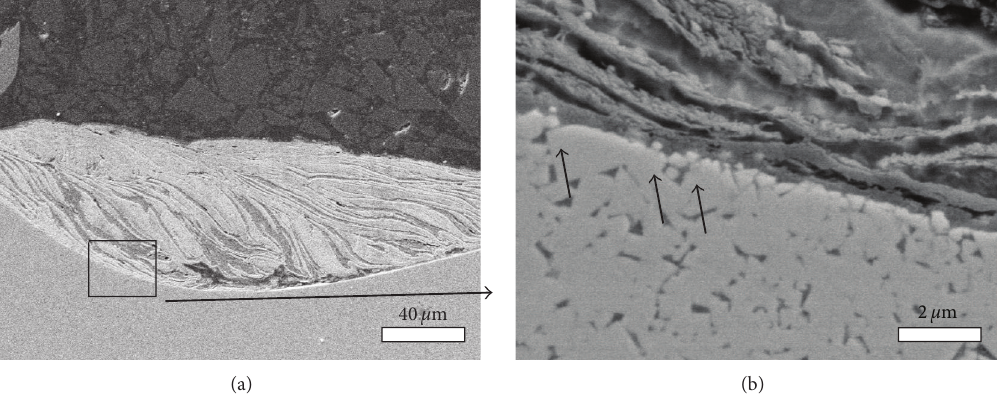
Figure 10: SEM picture of worn uncoated cutting tool in final state (after cutting length of 14669 m) with cutting parameters as follows: = 100 m/min, 𝑓 = 0.15 mm/rev, and 𝑎 𝑣 𝑐